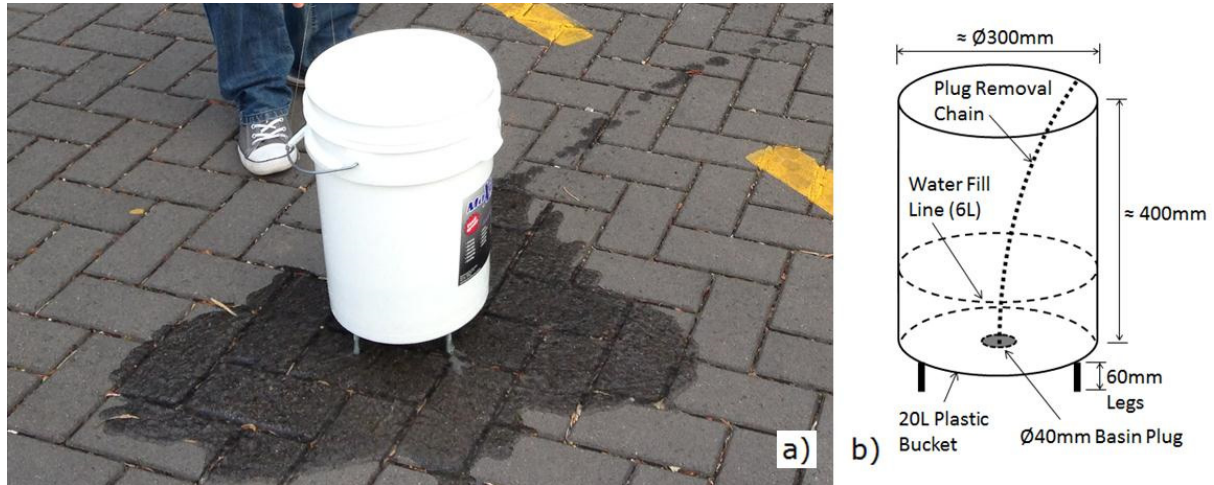
Figure 3. Stormwater infiltration field test (SWIFT) Infiltrometer used in this study. ( a ) SWIFT in use; ( b ) SWIFT